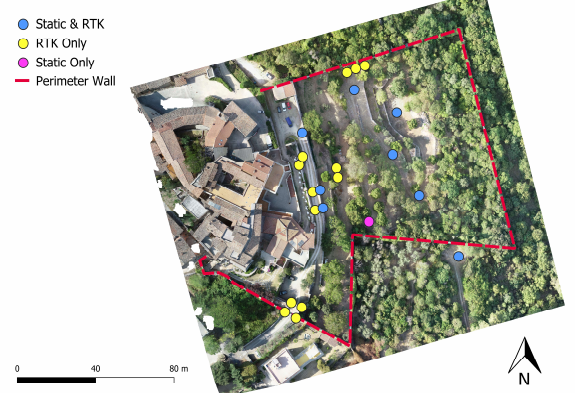
Figure 2 . Distribution of GCPs over the survey